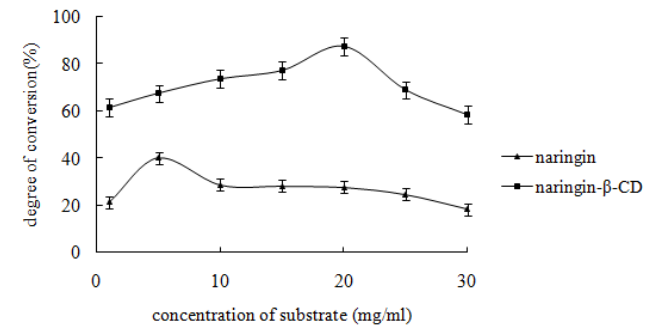
Figure 6. Effect of the concentration of the substrate. The substrate and snailase were weighed according to the weight proportion of 1:1. Glacial acetic acid and sodium acetate anhydrous buffer (pH 4.5) were added and the following solution concentrations were obtained: 1, 5, 10, 20, and 30 mg·mL − 1 . Subsequently, the buffer was incubated in a HH-4 digital constant temperature water bath at 37 °C for 24 h. Each point represents the mean ± SD ( n =